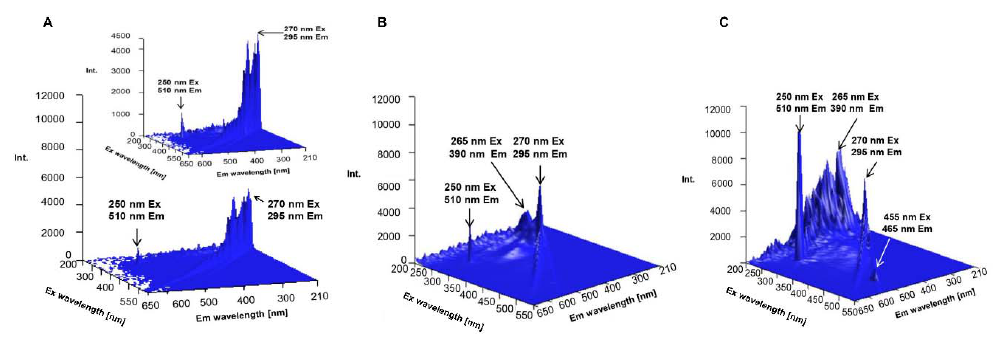
Figure 6. Fluorescence spectra of water ( A ), zinc nitrate ( B ), biologically synthesized ZnO NCs ( C ).